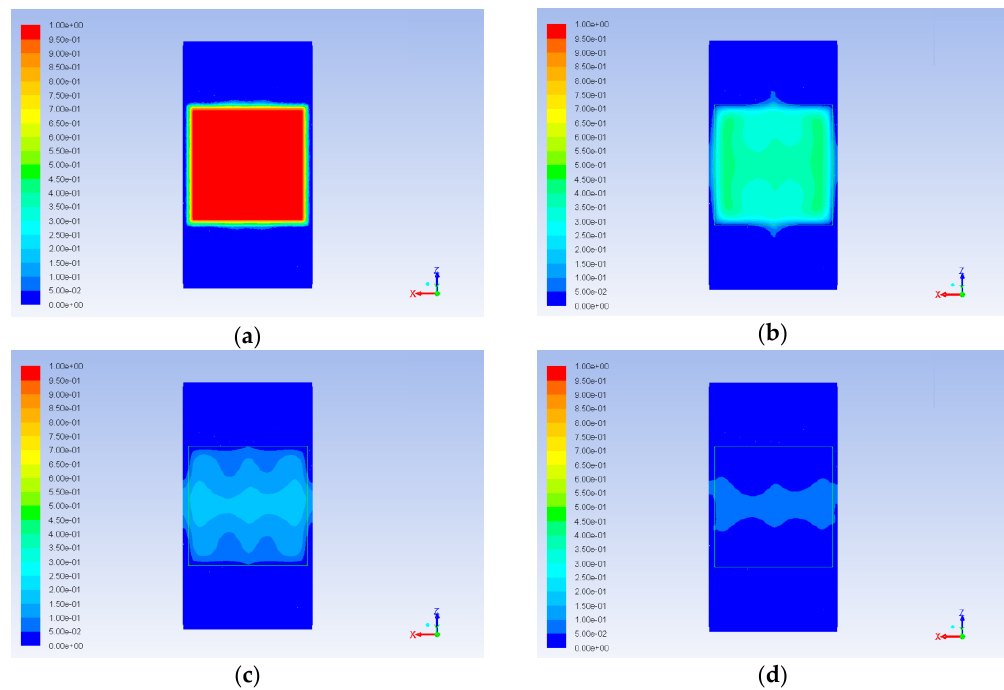
Figure 16. Aniline mass fraction profile (YZ middle cross section, the reactor walls are not shown, maximum value of the color map corresponds to pure aniline): ( a ) 500 seconds, ( b ) 10,000 seconds, ( c ) 20,000 seconds, ( d ) 30,000 seconds.